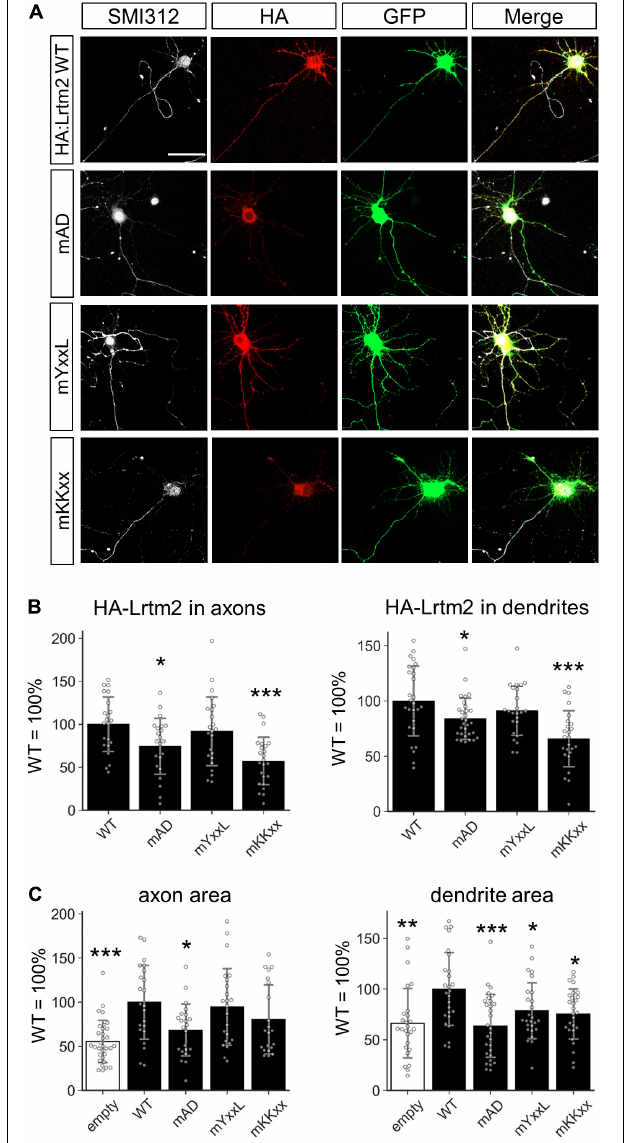
FIGURE 10 | Motifs that define the subcellular localization of Lrtm2. (A) Representative images. HA-Lrtm2 WT and mutants are detected by anti-HA epitope tag antibody ( red ). Transfected cells are identified by membrane-anchored CFP (GFP, green ). Scale bar , 50 µ m. Representative images for MAP2 immunostaining are indicated in Supplementary Figure 11 . (B) Quantification of HA-Lrtm2 WT or HA-Lrtm2 mutants in axons ( left , defined as a ratio of HA-positive area to SMI312-positive area) or dendrites ( right , defined as a ratio of HA-positive area to MAP2-positive area). n = 19–24 cells for each expression construct. Analysis of the neurites shapes is indicated in Supplementary Figure 12 . (C) Effects of HA-Lrtm2 WT on neurites’ areas. Gray circles indicate the individual value of each cell. * p < 0.05; ** p < 0.01; *** p < 0.001 in * p < 0.05; ** p < 0.01; *** p < 0.001 in ANOVA and post hoc Dunnett test, compared to WT values. Error bars ,